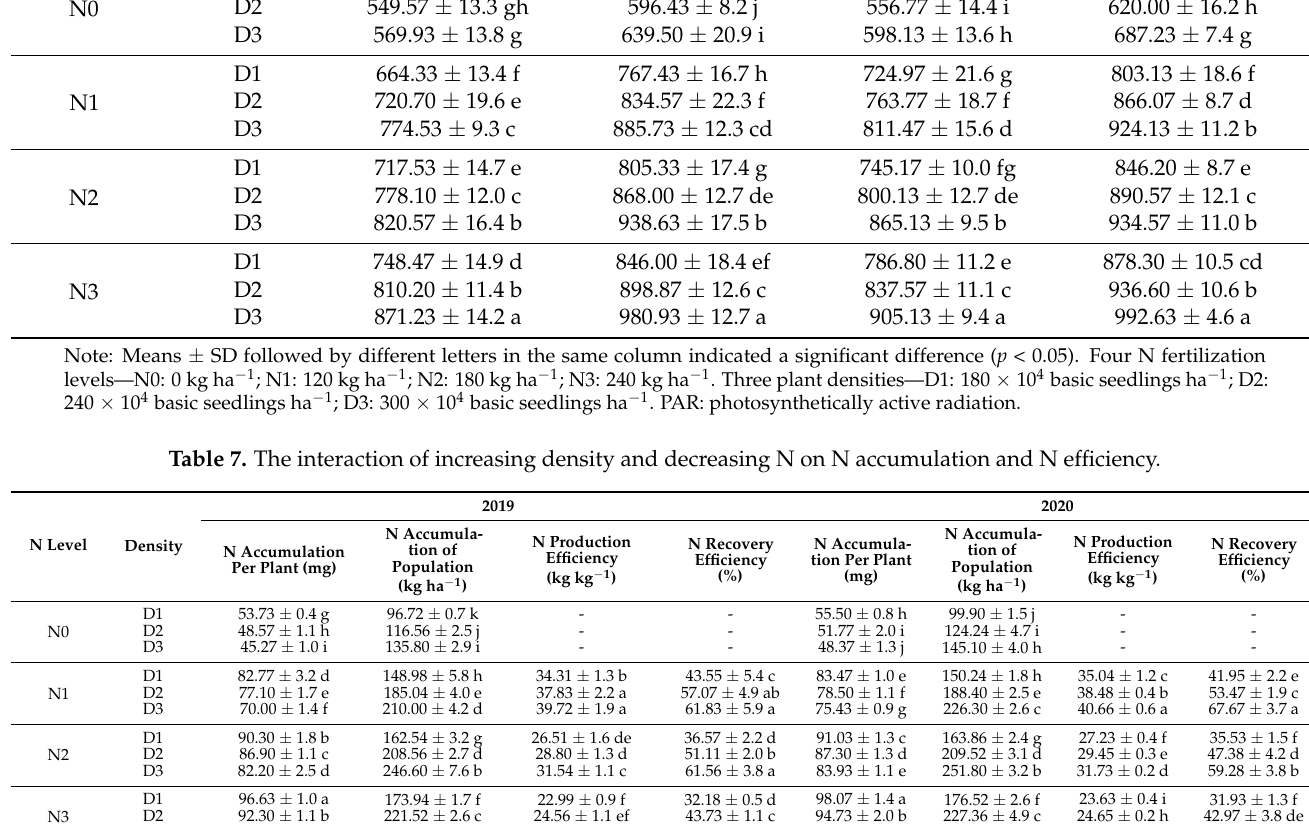
Table 6. The interaction of increasing density and decreasing N on canopy photosynthetically active radiation ( µ mol m − 2 s − 1 ).